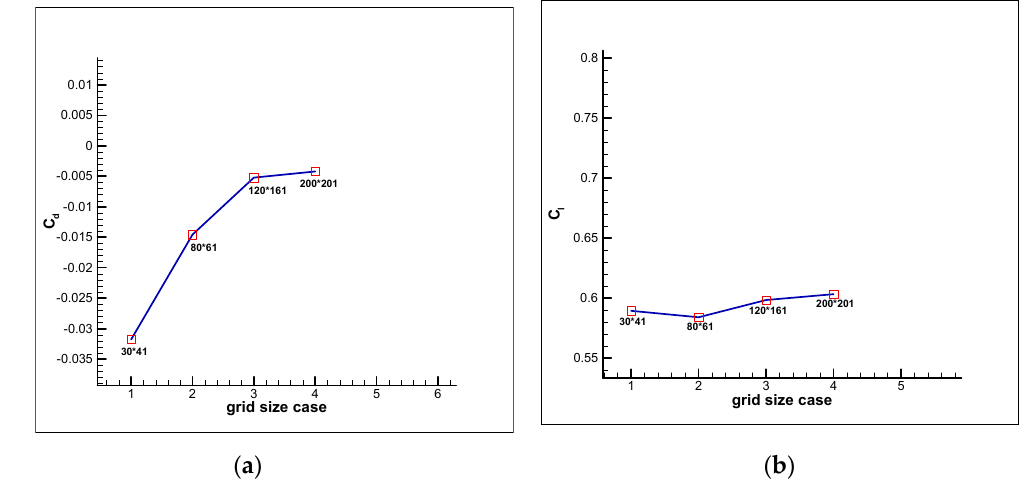
Figure 19. Effect of grid size on drag coefficient ( a ) and lift coefficient ( b ).